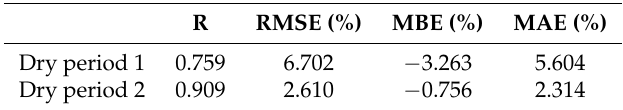
Table 4. Correlation coefficient (R) and statistical error comparison between measured and simulated clear-sky downward global solar radiation (DGSR) for two dry season periods (January–May and October–December), with the insertion of European Center for Medium-Range Weather Forecasts (ECMWF) atmospheric profiles, in Maroua in 2014. IHAZE = 10. Root-mean-squared error (RMSE), mean bias error (MBE) and mean absolute error (MAE) are relative values in